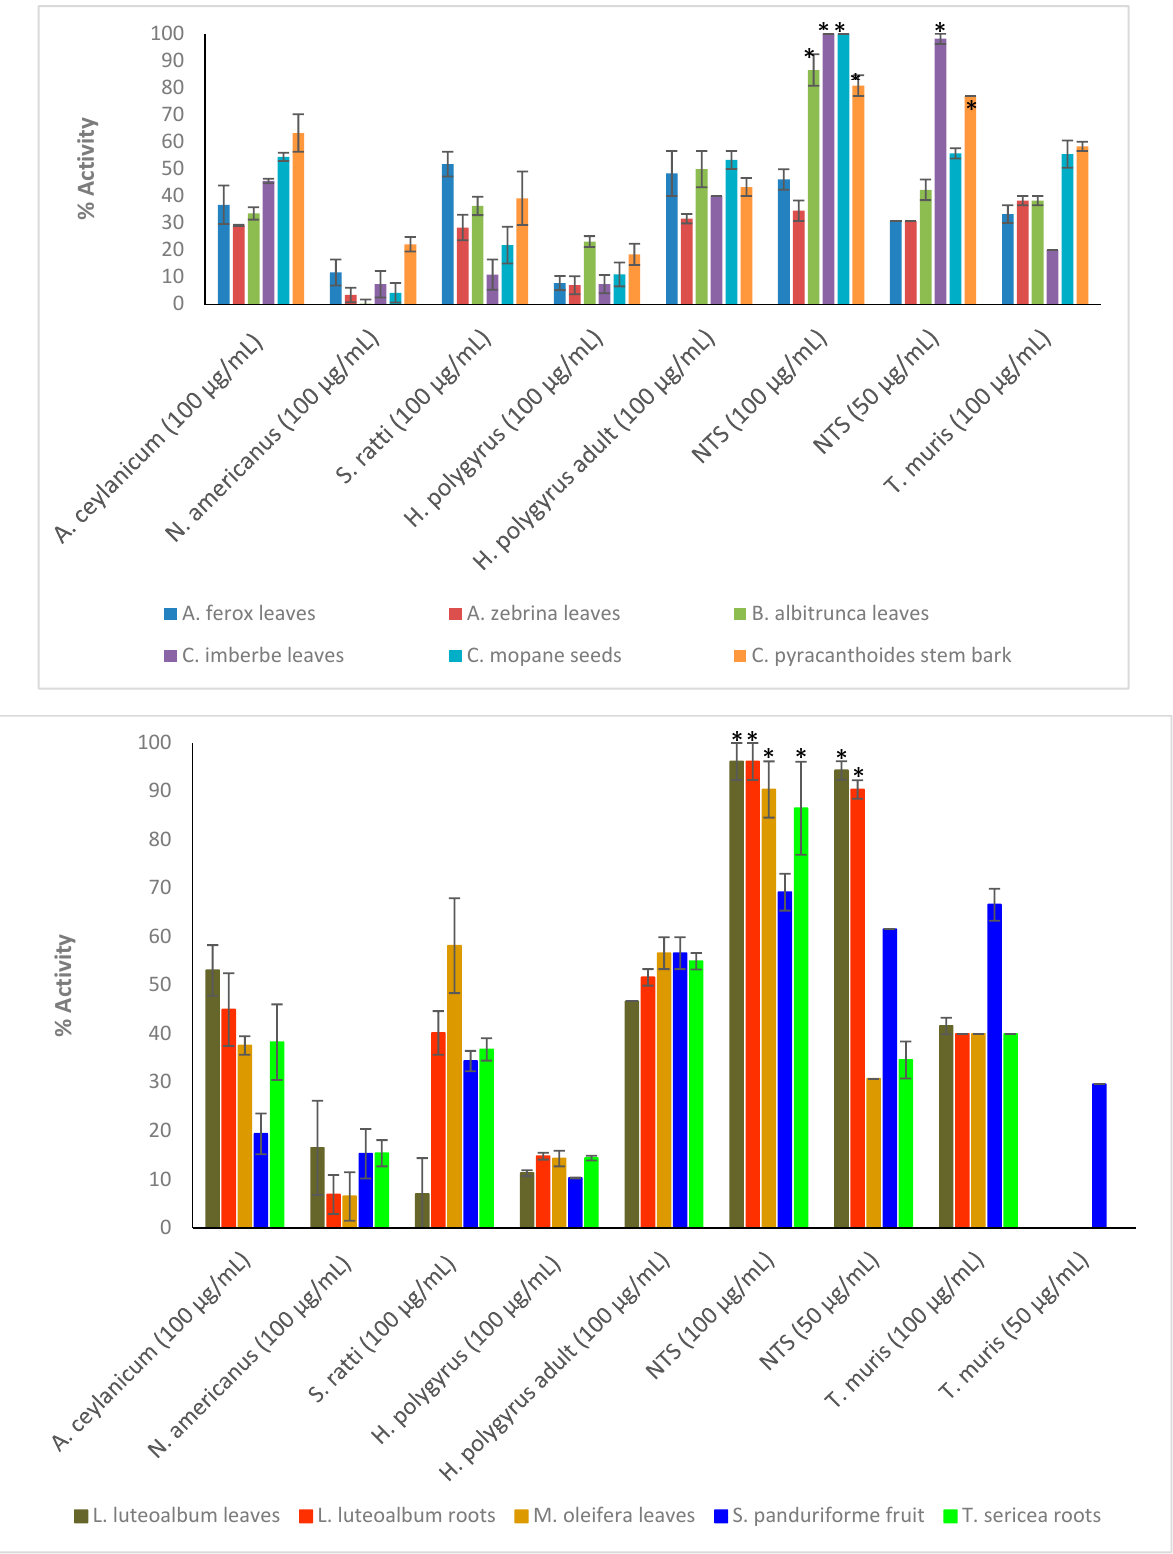
Figure 1. Anthelmintic activity of the plant extracts against the parasitic organisms. Activity based on three replicates. Statistical analysis (one way ANOVA, p ≤ 0.001, and an all pairwise multiple comparison procedure (Tukey Test), * extract activities determined to be significant) was performed using SigmaPlot 14.0 (Supplementary Materials, Table S3).